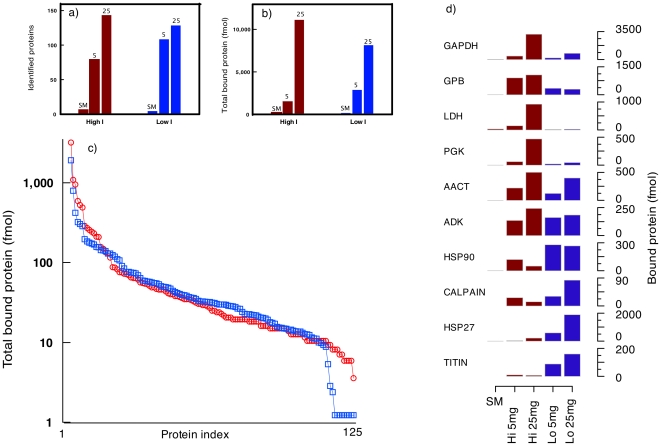
The effect of ionic strength on asymmetric protein loading.Prospectrum II beads were loaded with protein at two different levels (5 mg and 25 mg) in buffers at two different ionic strength values (Low, 20 mM sodium phosphate buffer, pH 7.5, I = 50 mM; High, 20 mM sodium phosphate buffer, pH 7.5 containing 150 mM NaCl, I = 200 mM). After loading, the proteins bound to the beads under each condition and the total bead loading (in fmol protein) were analysed by label-free quantification. The number of proteins identified are presented in panel a) and the total on-column yield of protein is given in panel b). The entire protein profile (irrespective of the identity of the proteins) is presented in panel c) and the behavior of specific proteins was highlighted for both sets of loadings and ionic strength values (panel d). Key: GAPDH: glyceraldehyde-3-phosphate dehydrogenase; GPB: glycogen phosphorylase b; LDH: lactate dehydrogenase; PGK: phosphoglycerate kinase; AACT: alpha actinin; ADK: adenylate kinase; HSP90: heat shock protein 90; HSP27: heat shock protein 27.